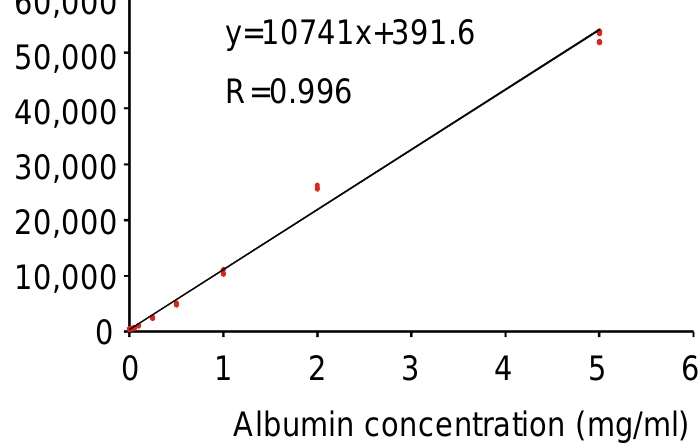
Figure 3. Scatter plots (red mark) and the approximate straight line of albumin concentration versus luminescence intensity ( n = 4 in each dose).